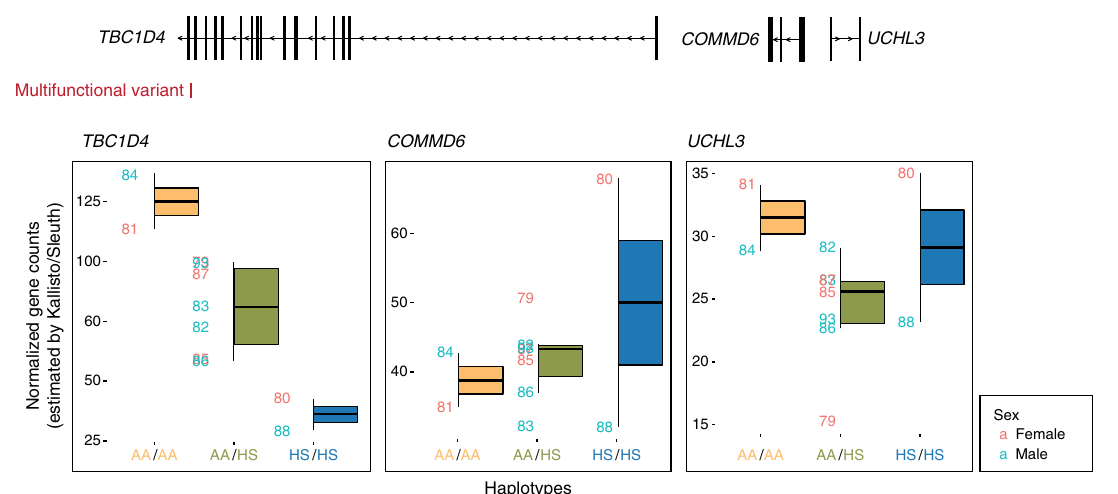
Fig. 4 Expression of genes within local contact domain. The intronic TBC1D4 cis -regulatory locus encodes an expression quantitative trait locus (eQTL) that acts on the TBC1D4 gene but not the immediate upstream COMMD6 or UCHL3 genes. For TBC1D4 , the amount of expression is higher when the ancestral allele (AA) is present compared with the human-speci fi c (HS) allele. Boxplots represent the interquartile range (IQR) with the median denoted by the middle line; whiskers extend to the largest/smallest value no further than 1.5 times the IQR. Expression values are provided in a Source Data fi le